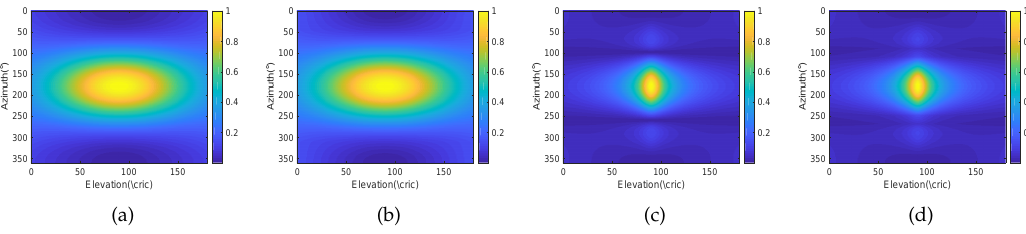
Figure 7. Normalized beampattern at 500 Hz and 700 Hz . ( a ) Original BCAVSA with f = 500 Hz ; ( b ) original BCAVSA with f = 700 Hz ; ( c ) coupling magnified BCAVSA with f = 500 Hz ; and ( d ) coupling magnified BCAVSA with f = 700 Hz .